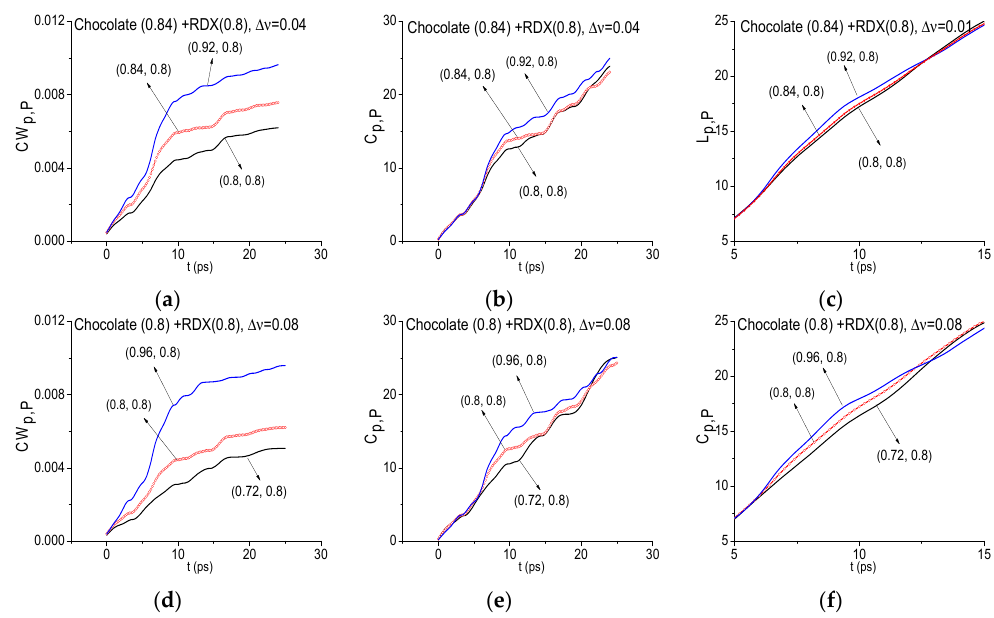
Figure 13. Time-dependent ICC’s CW p,P ( a , d ), C p,P ( b , e ) and L p,P ( c , f ) calculated for the frequency ν = 0.84 THz ( a – c ), 0.8 THz ( d – f ) with the spectral resolution Δ ν = 0.04 THz ( a – c ), 0.08 THz ( d – f ) for signal Chocolate and the standard RDX_Air signal.